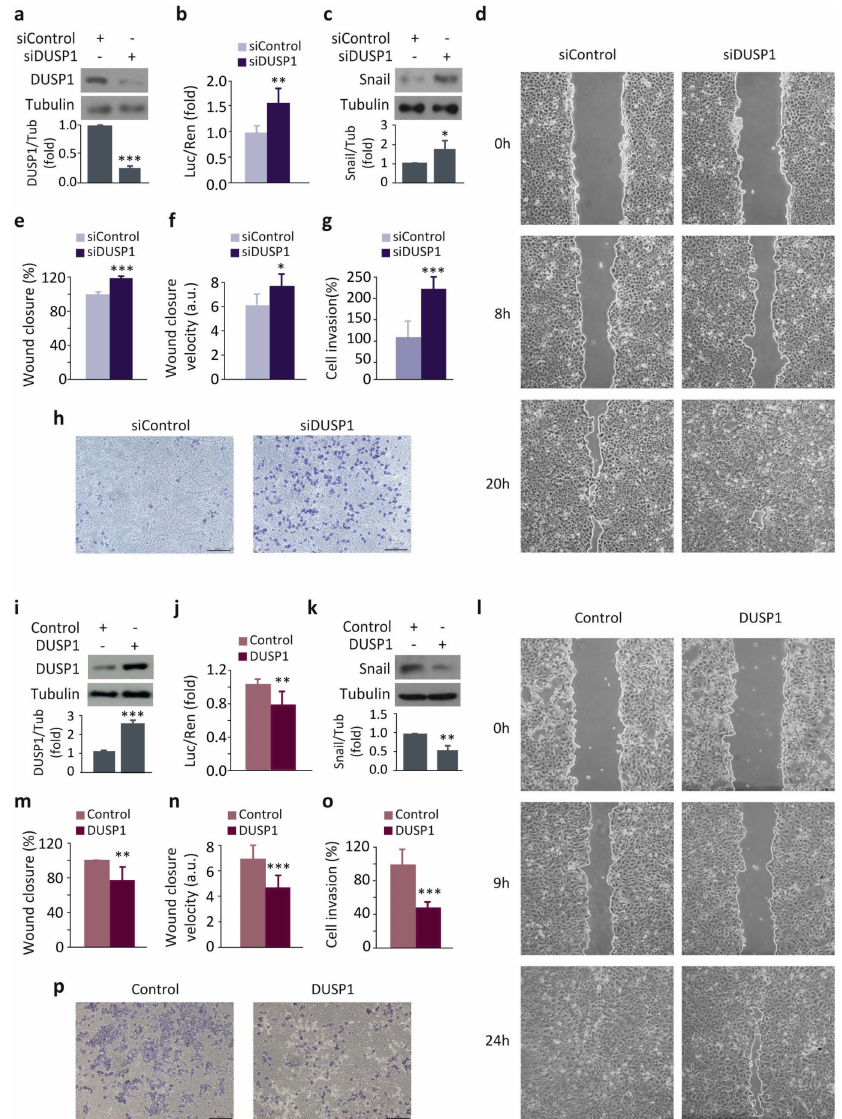
Figure 1. DUSP1 downregulates Snail expression and impairs cell migration and invasion in DU145 cells. ( a ) Cells were transfected for 48 h with the control siRNA (siControl) or the DUSP1 siRNA (siDUSP1) and expression levels of DUSP1 and Tubulin were determined by western blotting. ( b ) Cells were transfected for 48 h with the siControl or the siDUSP1 together with the Snail-Luc plasmid and luciferase activity was measured in cell extracts. ( c ) Cells were transfected as in a and expression levels of Snail and Tubulin were determined by western blotting. ( d – f ) Wound healing assay and measurement of wound closure area and velocity in cells transfected as in a . ( g , h ) Invasion capacity using transwell assays in cells transfected as in a . ( i ) Cells were transfected with a control vector (Control) or a vector encoding DUSP1 (DUSP1) and expression levels of DUSP1 and Tubulin were determined by western blotting. ( j ) Cells were transfected for 48 h with the Control or the DUSP1 vectors together with the Snail-Luc plasmid and luciferase activity was measured in cell extracts. ( k ) Cells were transfected with the Control or the DUSP1 vectors and expression levels of Snail and Tubulin were determined by western blotting. ( l – n ) Wound healing assay and measurement of wound closure area and velocity in cells transfected as in i . ( o , p ) Invasion capacity using transwell assays in cells transfected as in i . For all the results, data are shown as the mean ± SEM of at least three independent experiments. For migration and invasion assays, pictures are from one representative experiment of three with similar results. Student’s t test: * 0.01 < p < 0.05; ** 0.001 < p < 0.01; *** p <